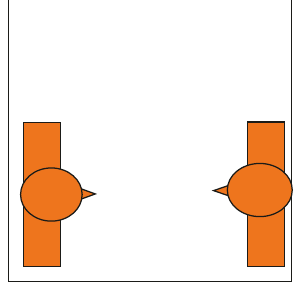
Figure 14: Facing each other